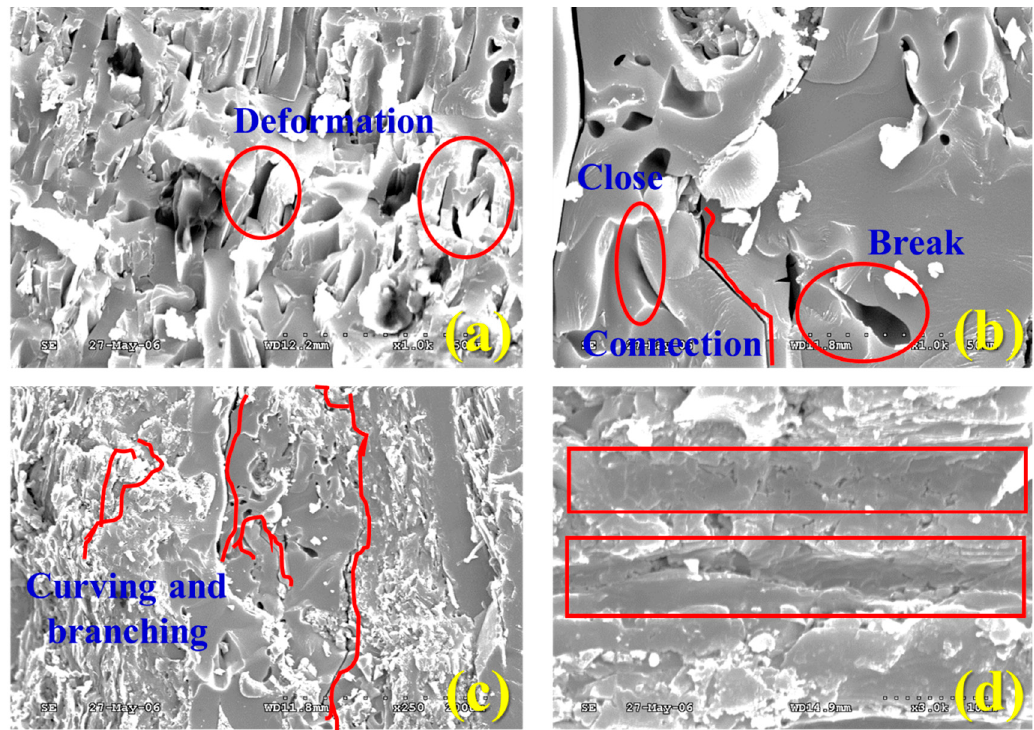
Figure 13. SEM images of microstructures of damaged gas-bearing coal; ( a ) Primary pores were deformed under magnification of 1000 times. ( b ) Pores were damaged, closed and then connected under magnification of 2000 times. ( c ) Tensile cracks were bent and split, which were densely distributed under magnification of 250 times. ( d ) Fracture surface appeared as step-shaped and river-shaped fractures under magnification of 100 times. Red rectangles denote the location of fractures.